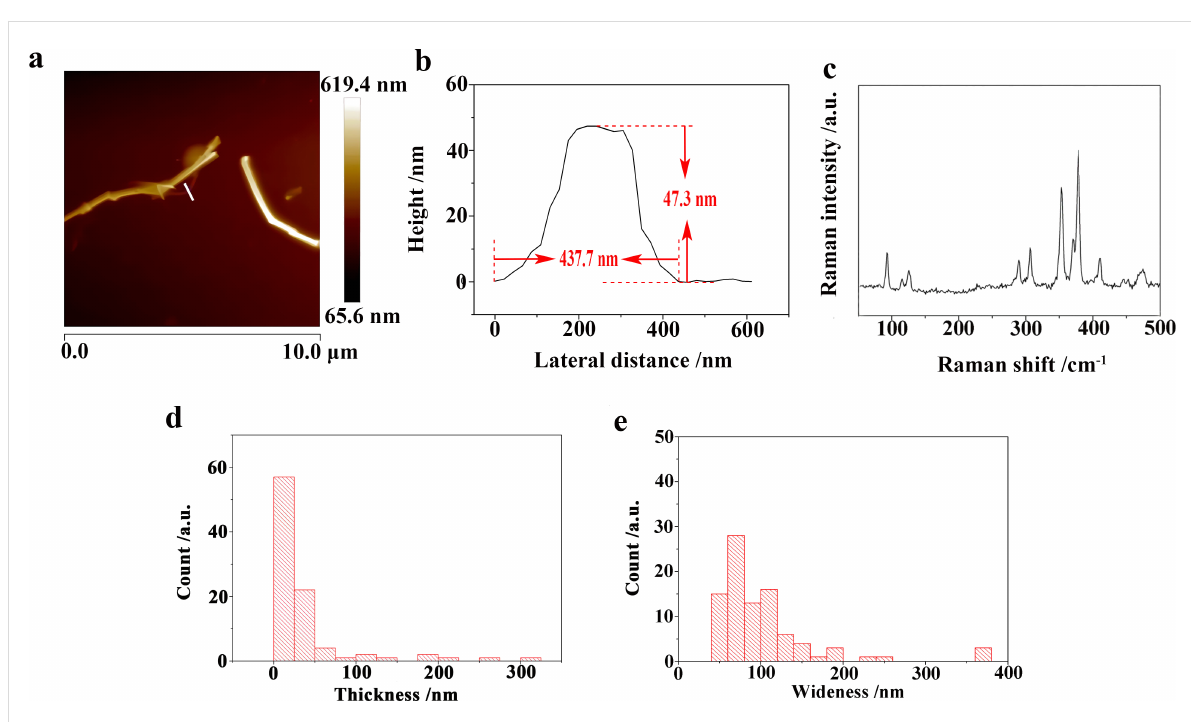
Figure 7: (a) Height distribution of KP 15 nanowires after liquid exfoliation. (b) Cross sections of KP 15 nanowires after liquid exfoliation. (c) Raman spectra of KP 15 nanowires after liquid exfoliation. (d) Thickness histograms of KP 15 nanowires after liquid exfoliation. (e) Width histograms of KP 15 nanowires after liquid